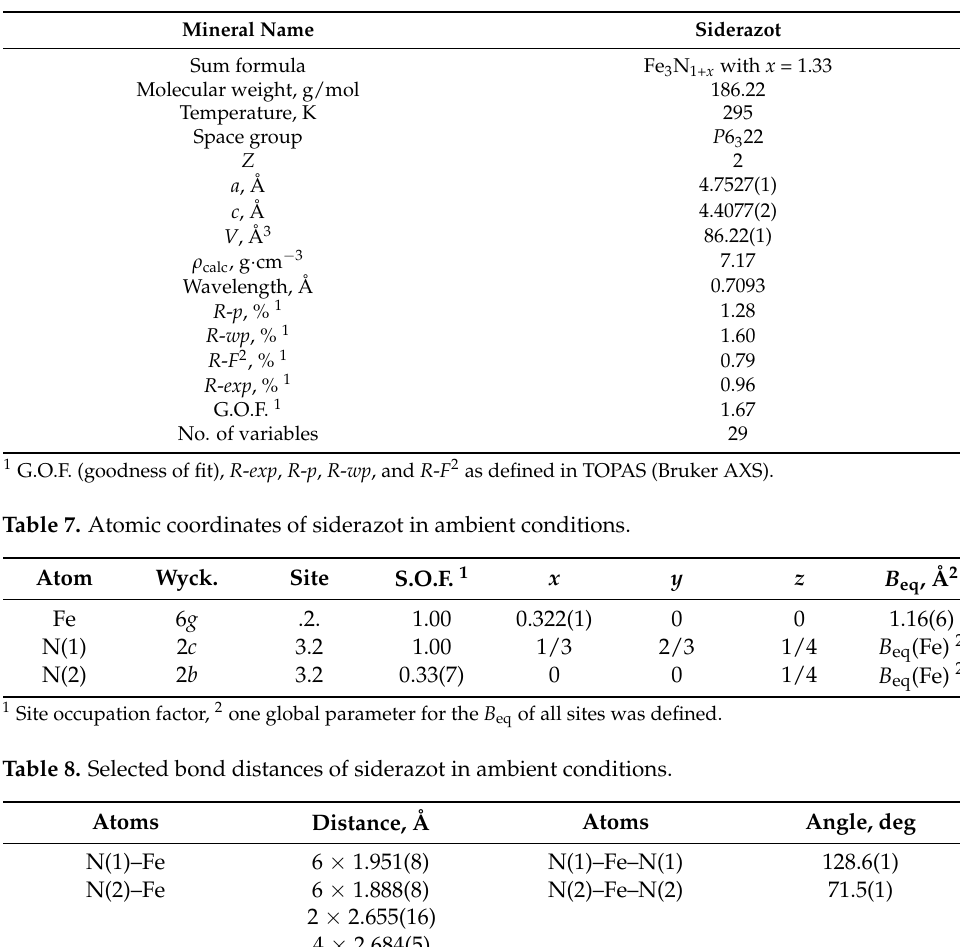
Table 6. Selected crystallographic and Rietveld refinement data of siderazot.